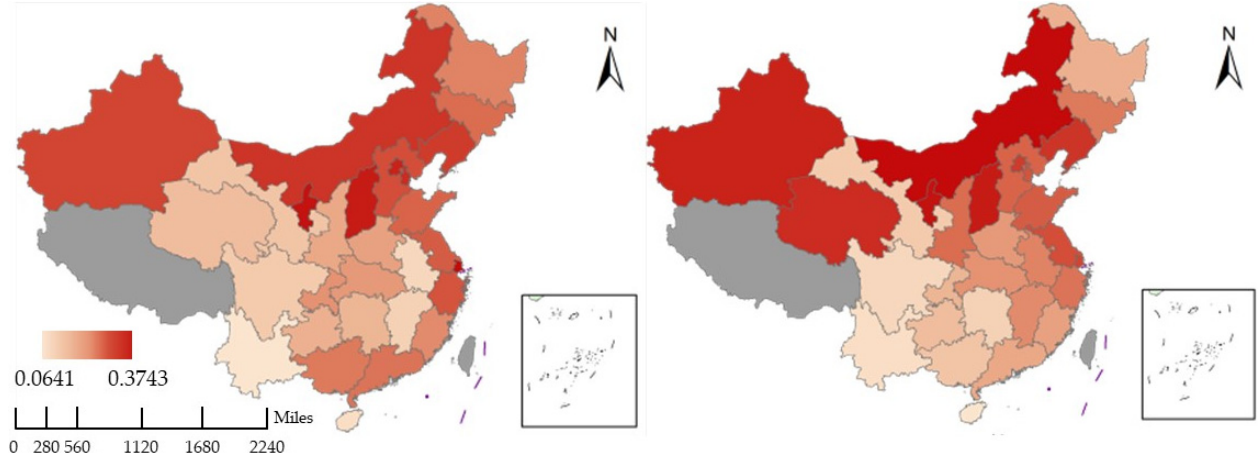
Figure 2. Calculated EPI in 2004 ( left ) and 2019 ( right ) for 30 Chinese provinces, autonomous regions, and municipalities.